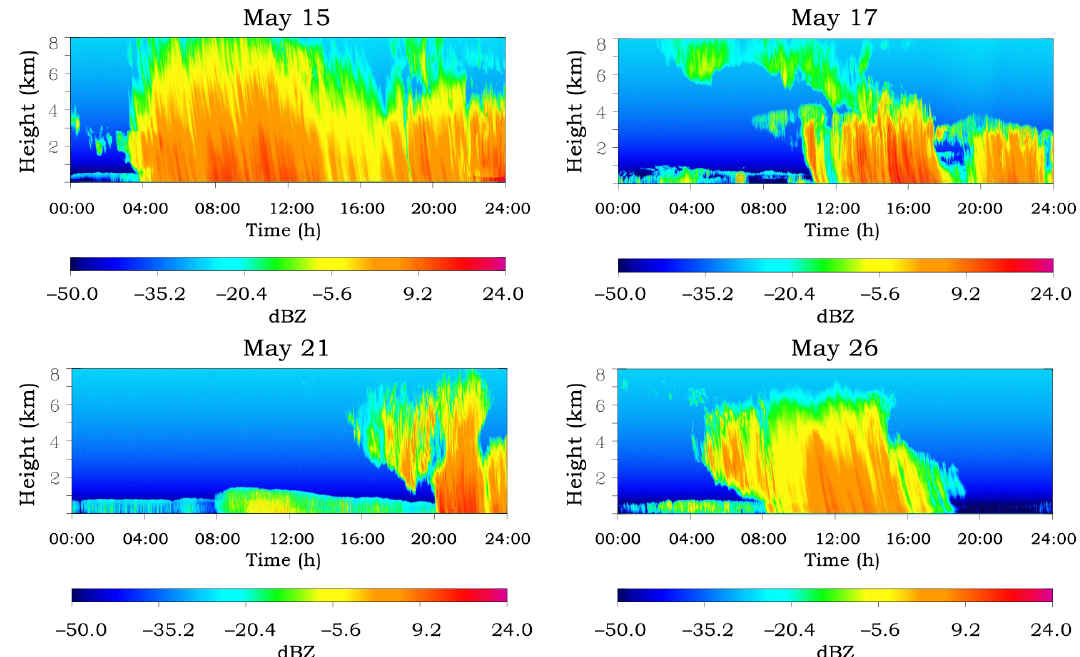
Figure 6. KAZR reflectivities (dBZ) for snow event systems as observed at the NSA Barrow Climate Research Facility site. Areas of orange and red indicate likely periods with